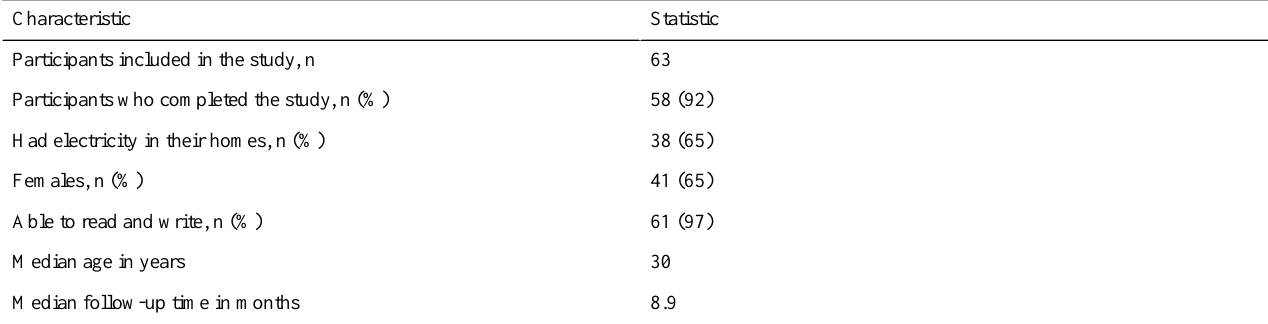
Table 1. Participant characteristics.